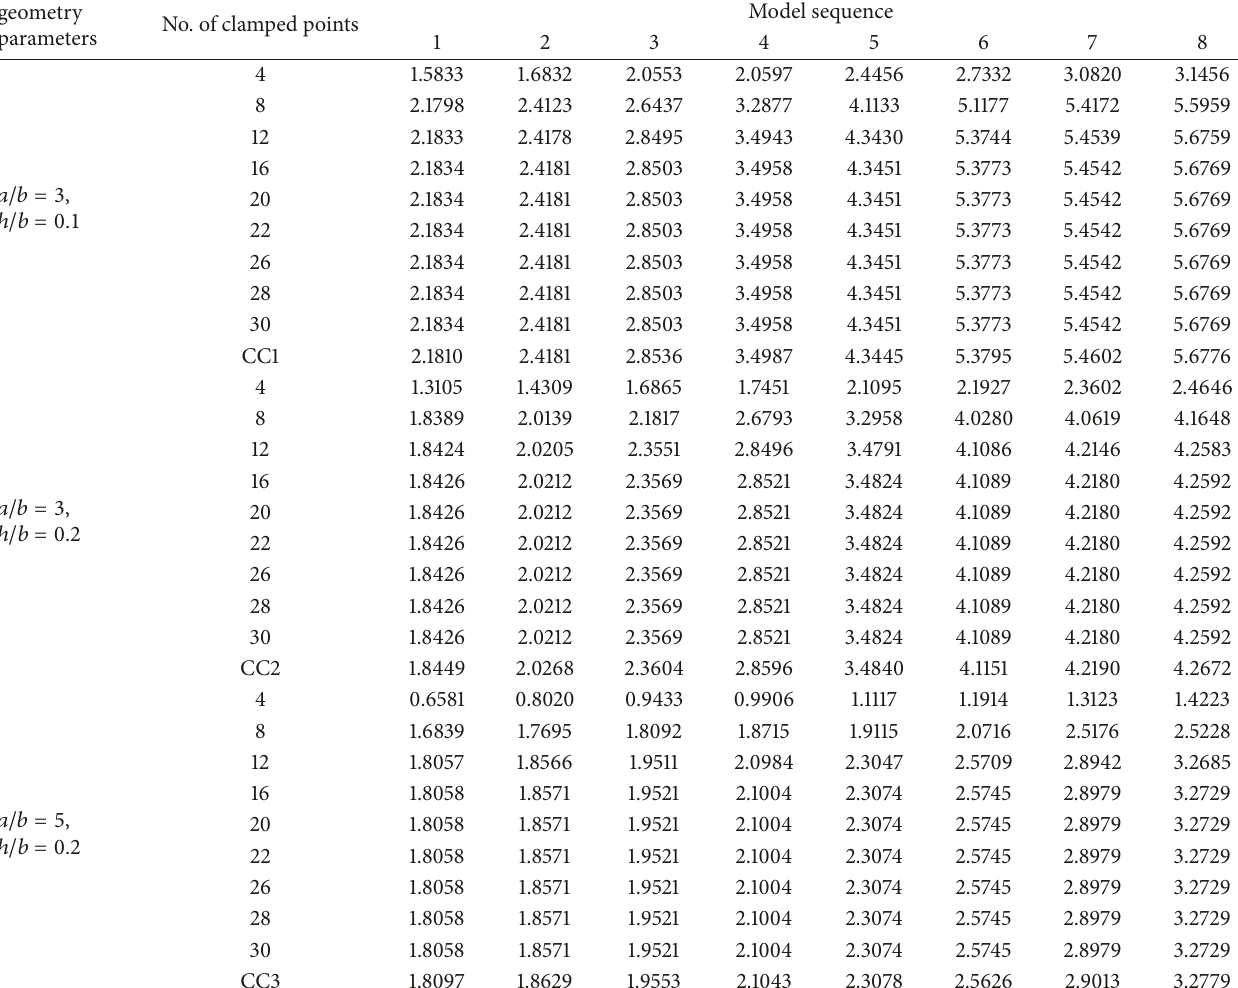
Table 6: Frequency parameters Ω = 𝜔𝑏 2 (𝜌ℎ/𝐷) 1/2 /𝜋 2 for the multipoint-supported plate with different geometry parameters and numbers of clamped